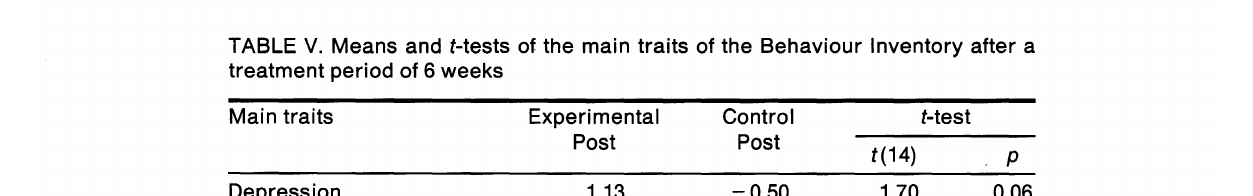
TABLE VI. (Nearly) significant effects (p-values) on memory and affective behaviour of AD patients by combined short-term TENS and massage treatment, compared with those of short-term TENS and massage applied